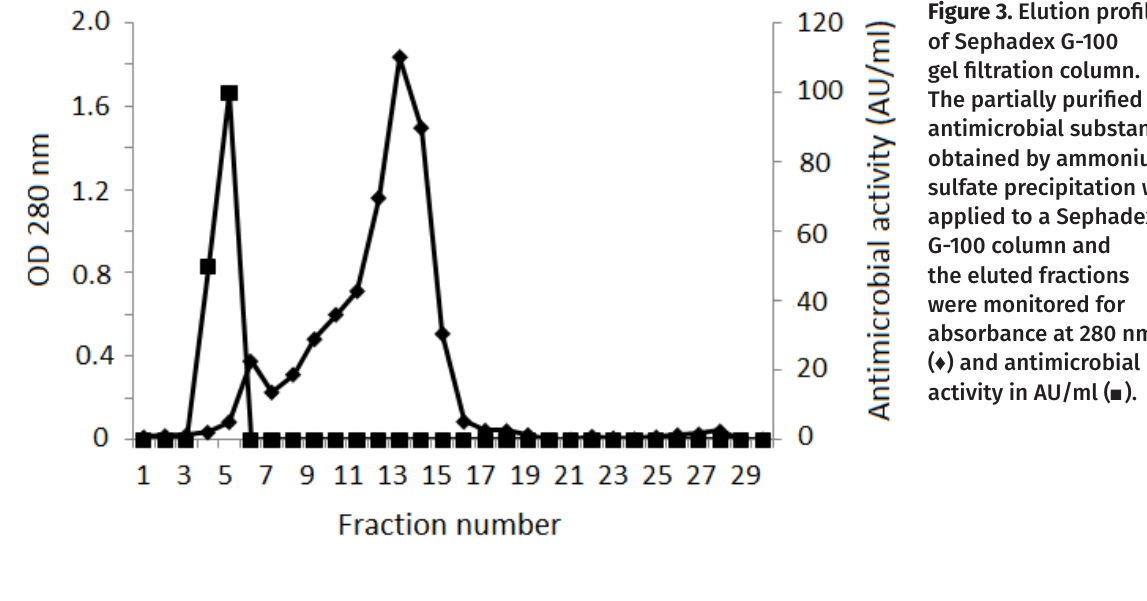
Figure 3. Elution profile of Sephadex